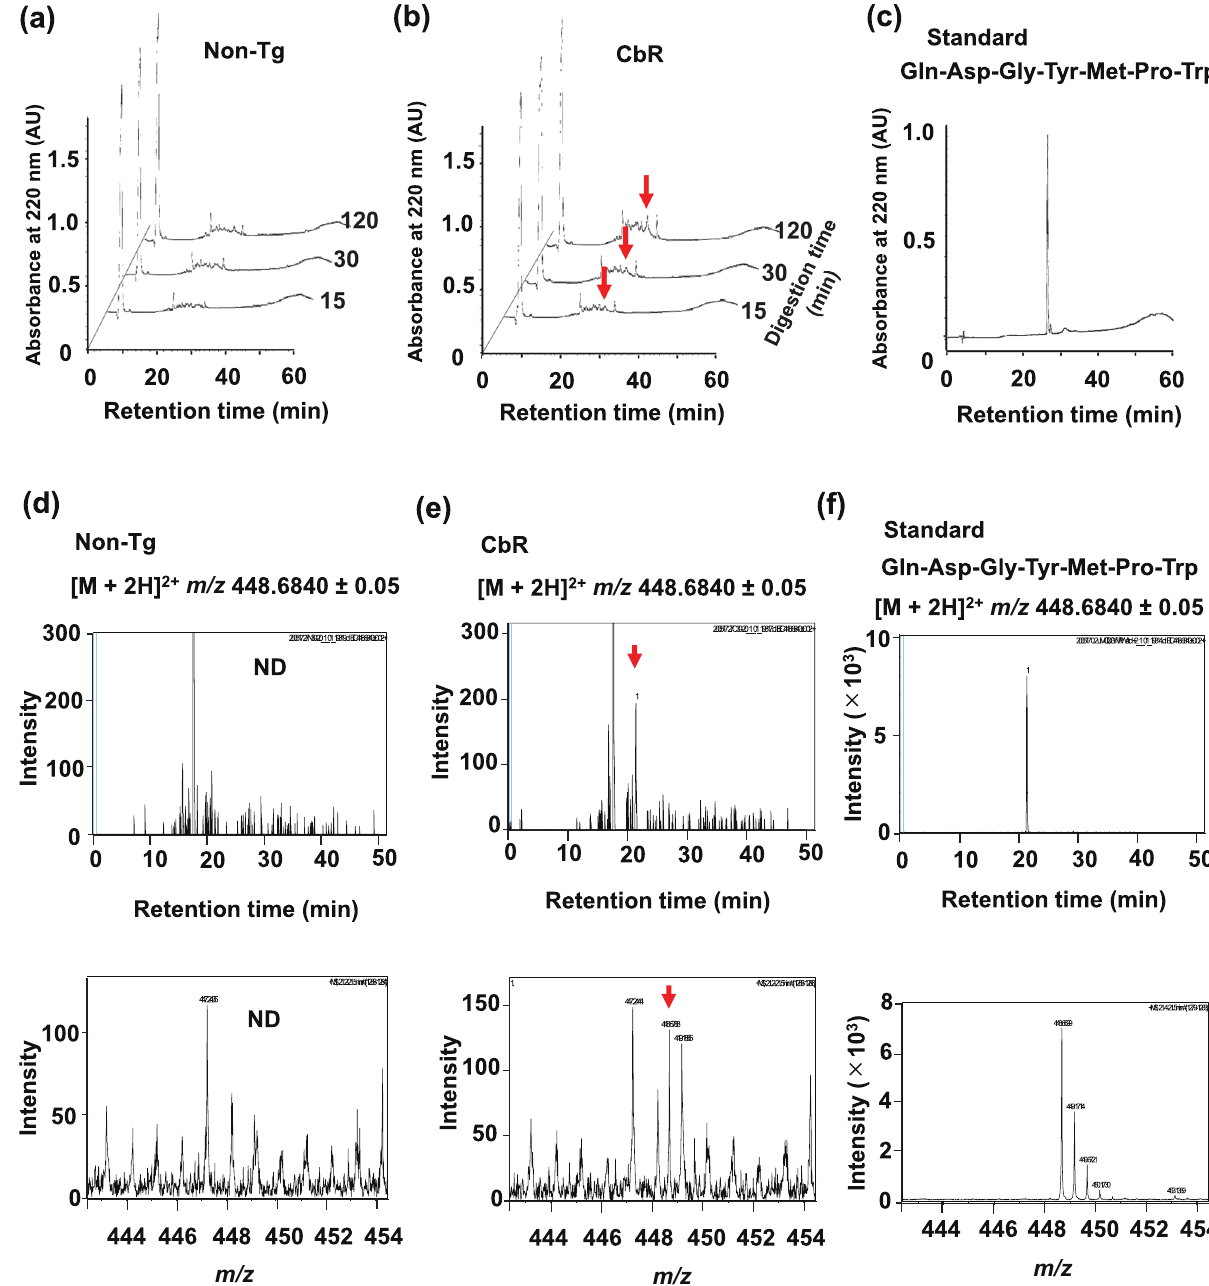
Fig. 4 Chymotrypsin hydrolysates of non-Tg and CbR determined by HPLC. Chromatograms of chymotrypsin-digested glutelin-derived peptides from nontransgenic (non-Tg; a ) or Cblin-enriched (CbR; b ) rice, and synthetic standard peptide Gln-Asp-Gly-Tyr-Met-Pro-Trp ( c ). Fraction at 27.0 min was collected and further analyzed by LC – TOF/MS while monitoring [M + 2H] 2 + of m / z 448.6840 for Gln-Asp-Gly-Tyr-Met- Pro-Trp ( d – f ). Arrows indicate MS signals corresponding to RT (21.4 min, upper panel) and m / z ([M + 2H] 2 + : m / z 448.6840, lower panel) of standard Gln-Asp-Gly-Tyr-Met-Pro-Trp. AU, arbitrary units; ND, not